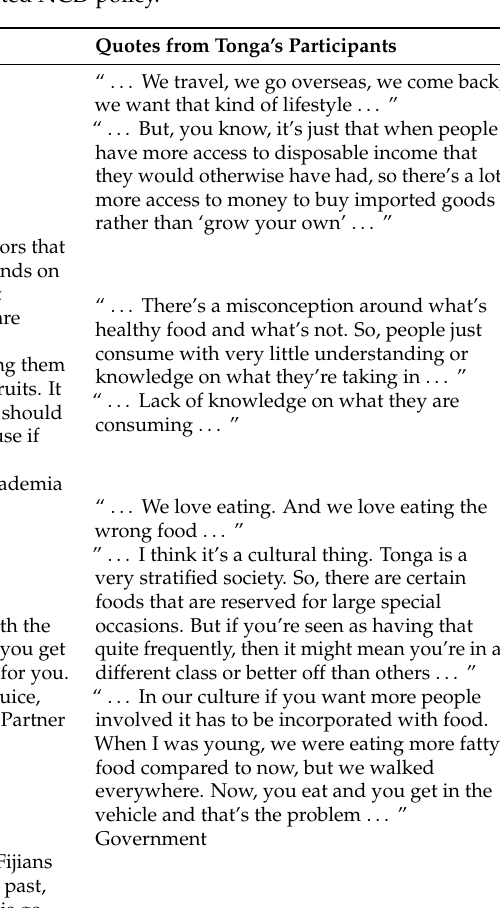
Table 1. Mediating factors influencing diet-related NCD